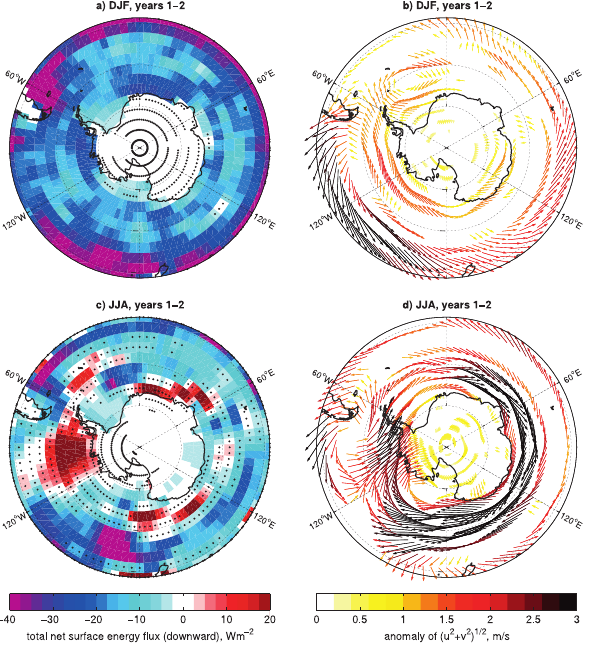
Figure 12. Ensemble-mean simulated Southern Hemisphere sum- mer (DJF, top) and winter (JJA, bottom) total net surface energy flux (latent and sensible heat, short- and long-wave radiation, a, c ) and 10m wind anomalies (b, d) for integration years 4–6 of the SUPER1 ensemble. (a, c) : black dots indicate grid points where changes are nonsignificant at the 95% confidence level; (b, d) : only changes statistically significant at 95% confidence for at least one of the wind components are